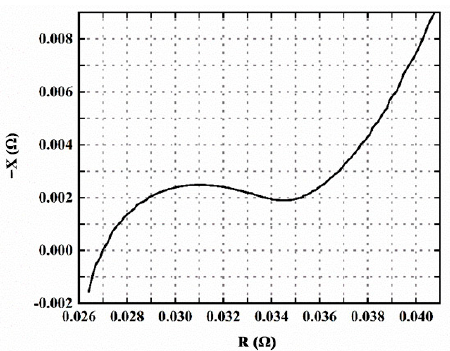
Figure 1. 18,650 LiFePO4 Li-ion battery electrochemical impedance spectrum .